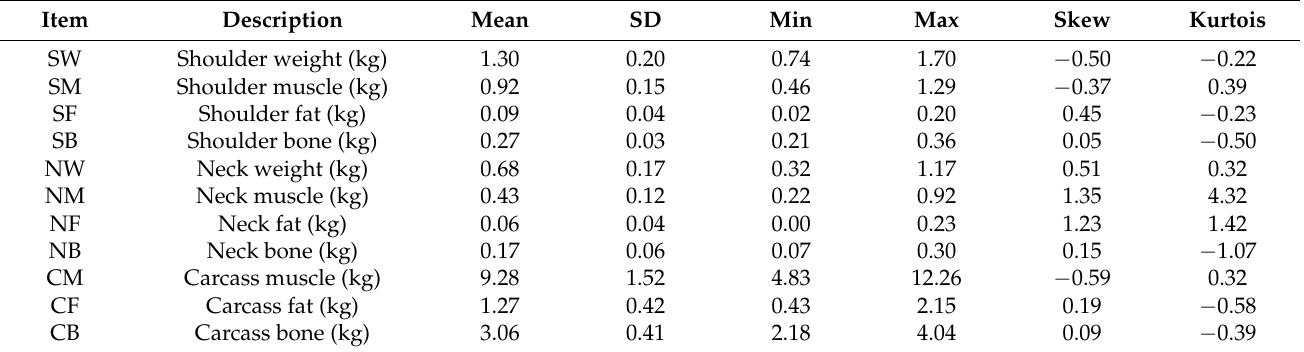
Table 1. Descriptive analyses of the data measured in live animals ( n = 40) fattening Blackbelly sheep.